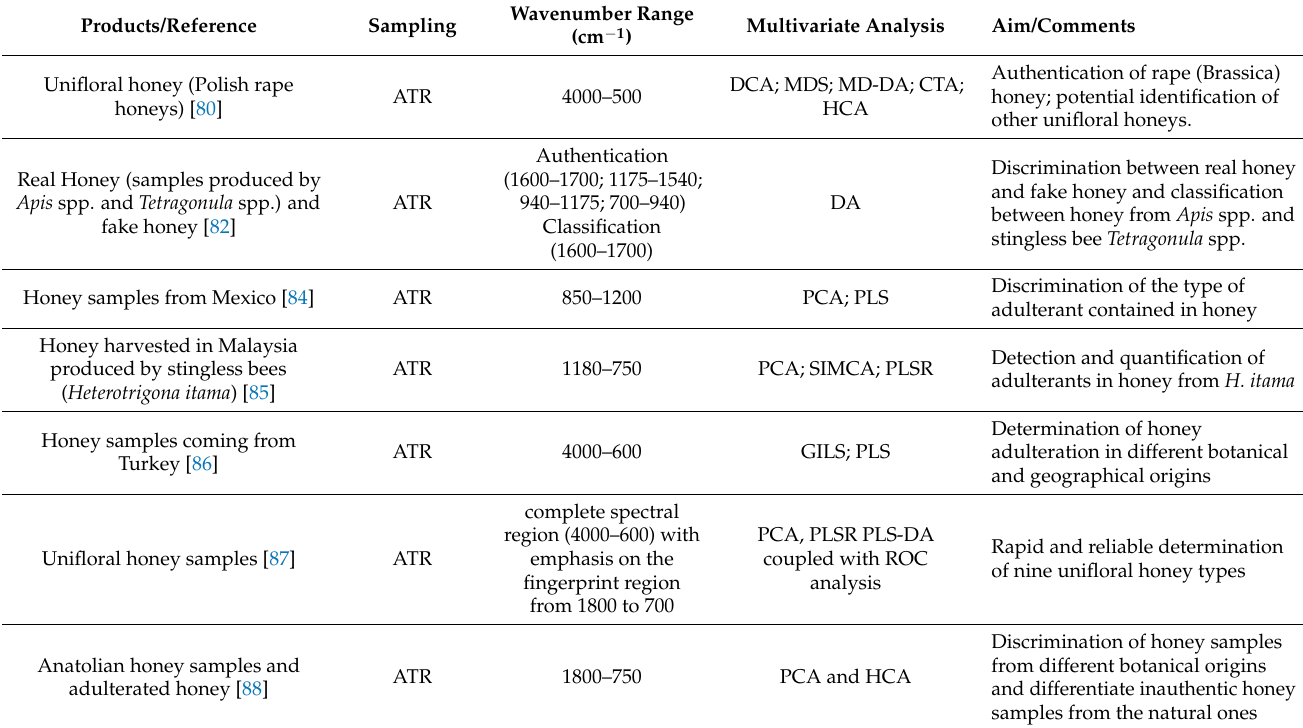
Table 3. Application of FT-MIR spectroscopy to the analysis of honey.